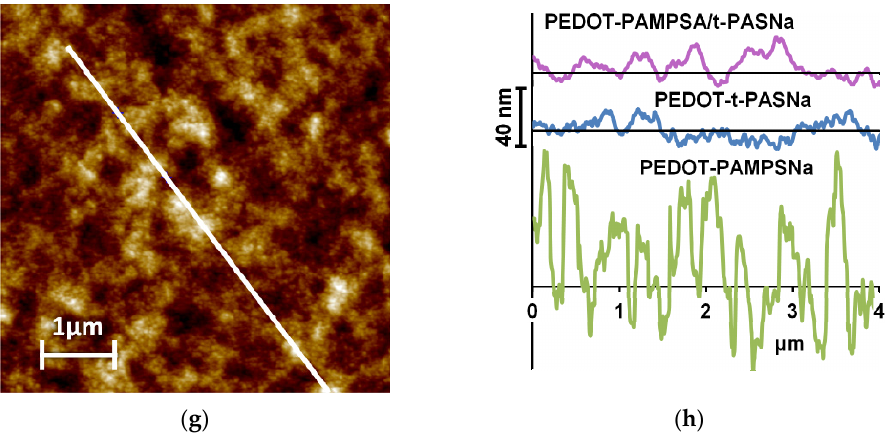
Figure 7. AFM images of PEDOT films obtained in the presence of PAMPSA ( a ), t-PASA ( b ), PAMPSA/t-PASA (1:1) ( c ), their cross-section profiles along white line on the images ( d ), PAMPSNa ( e ), t-PASNa ( f ), PAMPSNa/t-PASNa ( g ) and their cross-section profiles ( h ).